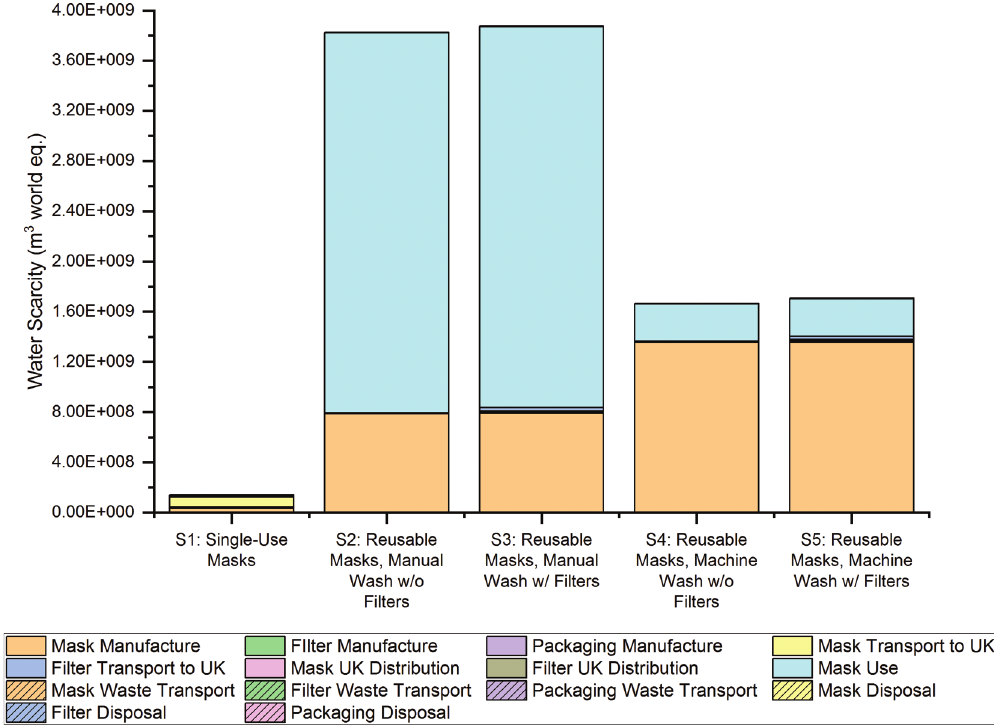
Water Scarcity results generated by each face mask scenario.